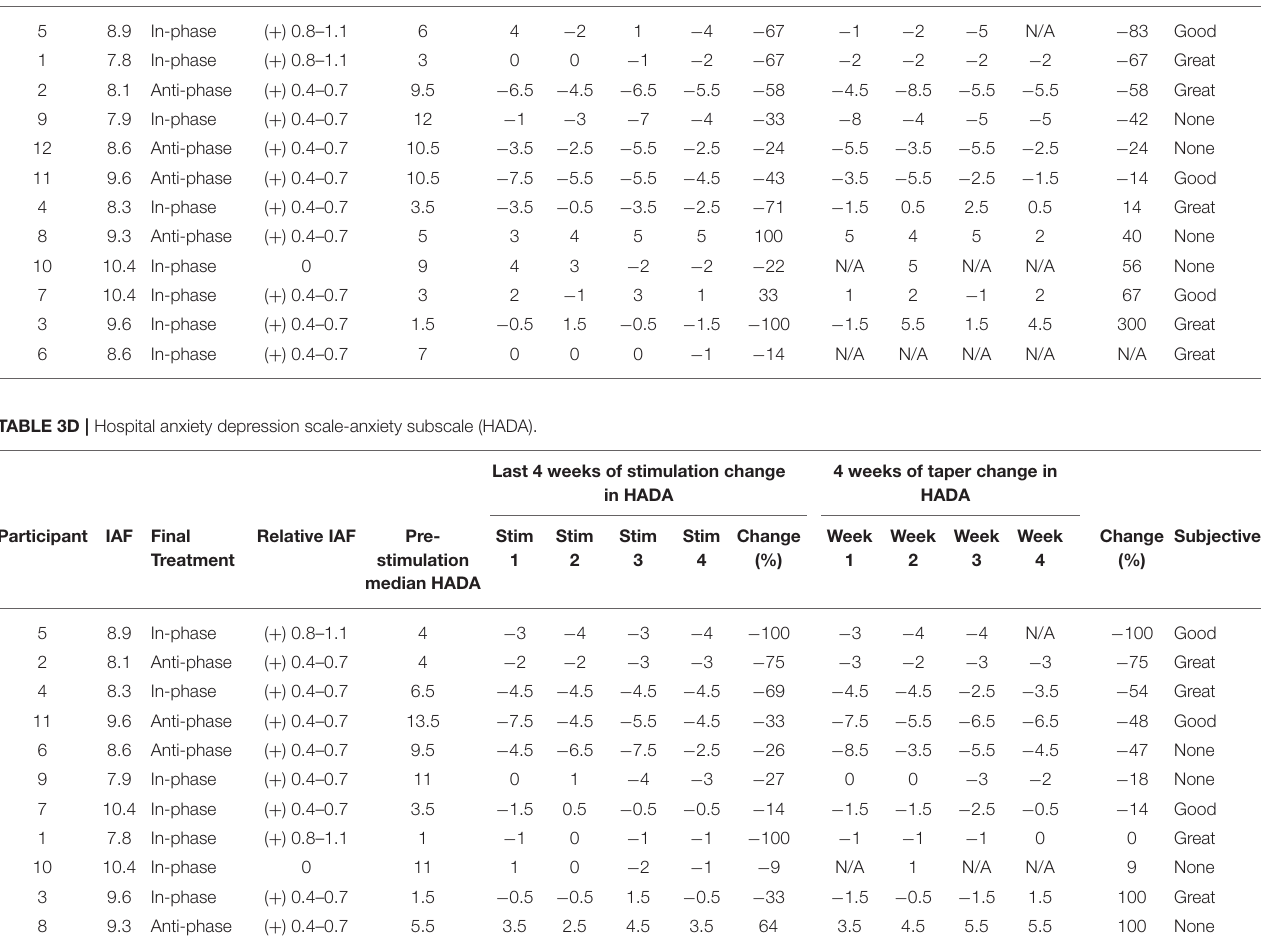
Last 4 weeks of stimulation change 4 weeks of taper change in in HADD HADD